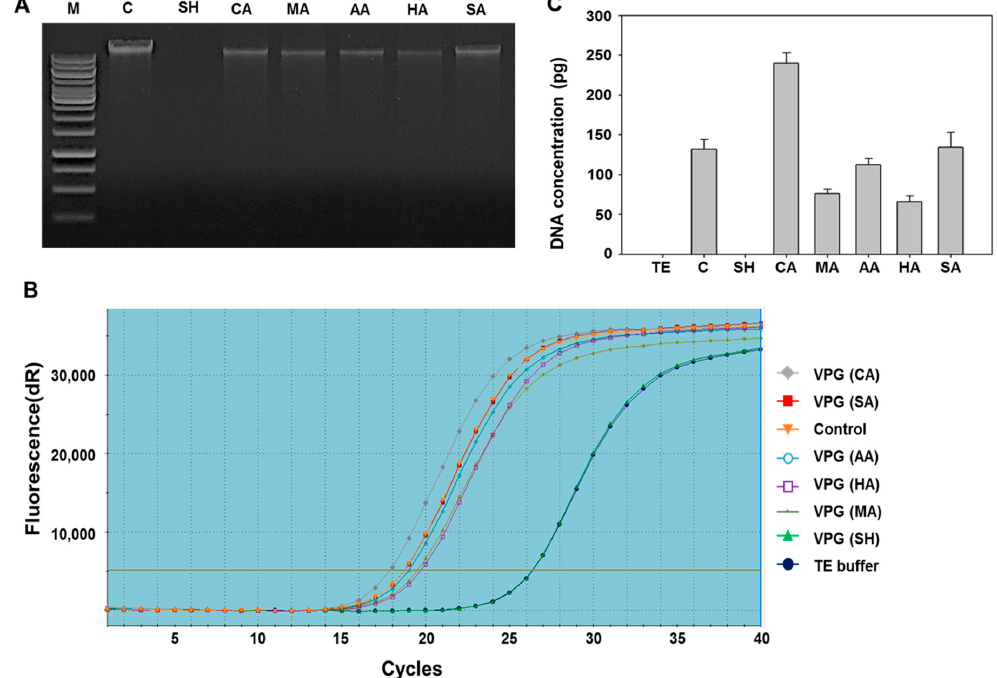
Figure 1. ( A ) Agarose gel (1%) electrophoresis of genomic DNA extracted from Vibrio parahaemolyticus ghosts (VPGs) treated with MICs (minimum inhibitory concentration) of sodium hydroxide (SH), citric acid (CA), maleic acid (MA), acetic acid (AA), hydrochloric acid (HA),